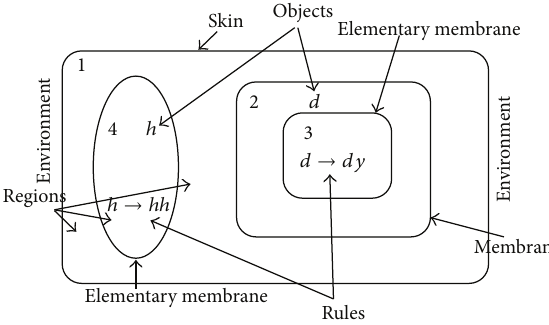
Figure 2: Simple membrane structure